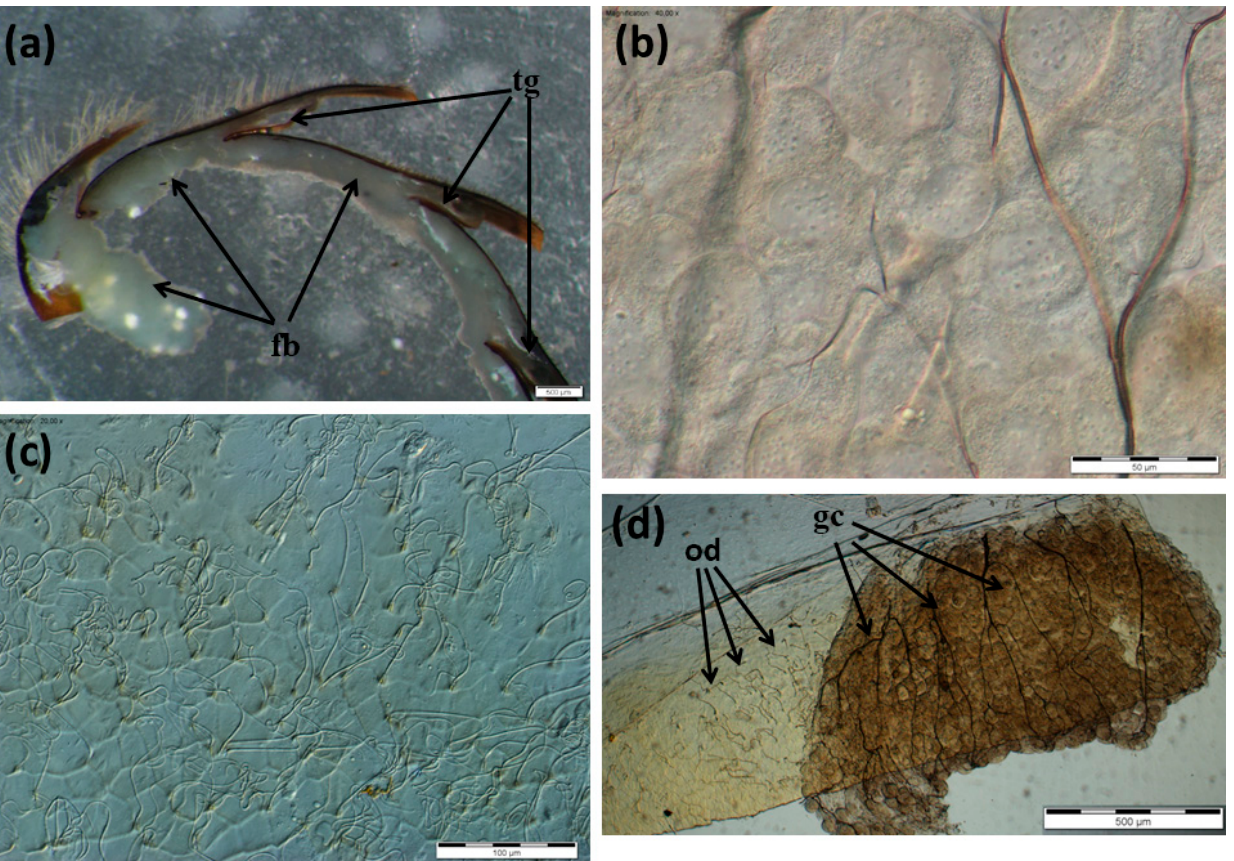
Figure 5. Tergal glands in queens. ( a ) Longitudinal section through the outer layers (cuticle along with the fat body and glands) of a queen abdomen; ( b ) gland cells; ( c ) outlet ducts; ( d ) the intersegmental membrane with the cells of the gland and their outlet ducts. tg—tergal glands; fb—fat body; od—outlet ducts; gc—gland cells .